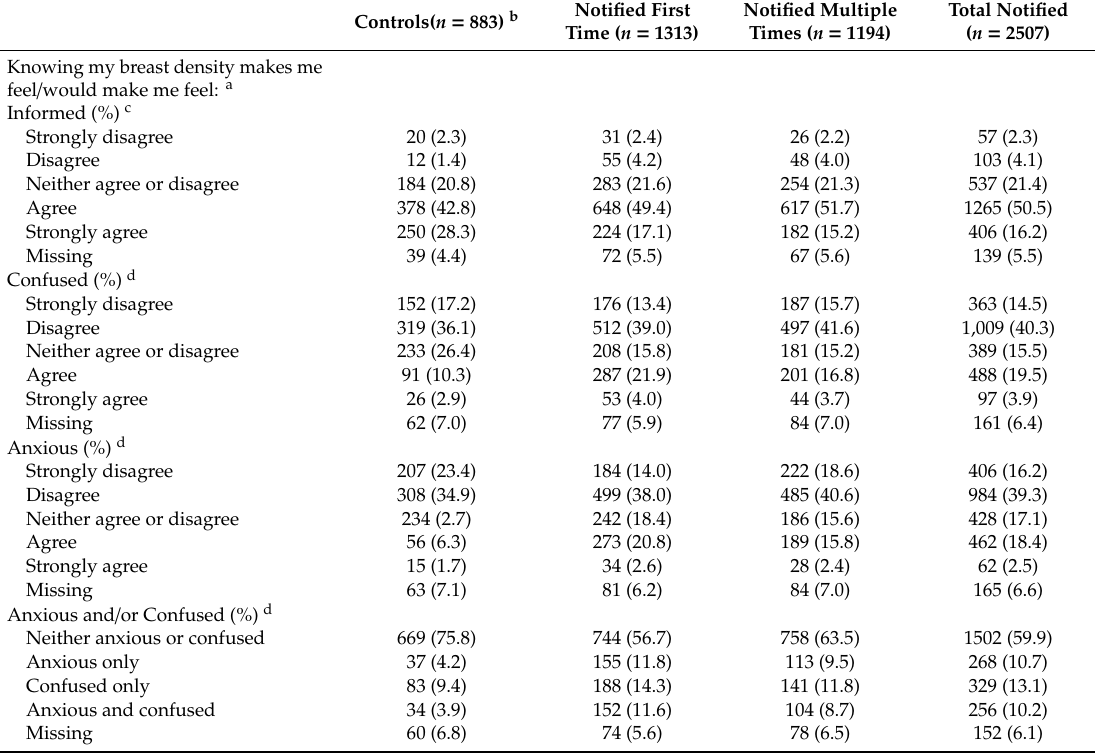
Table 2. Descriptive summary of women’s self-reported psychological reaction to the question “Knowing my breast density makes me feel / would make me feel ... ” a for controls ( n = 883), all notified women ( n = 2507) and separately for women notified for the first time ( n = 1313) and for those notified multiple times ( n =